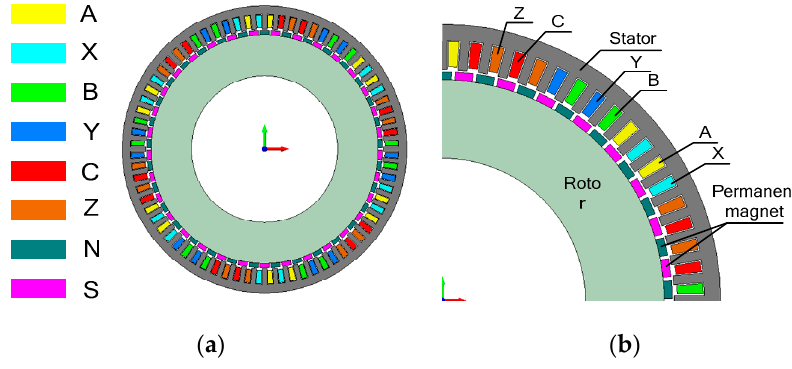
Figure 1. The structure of the DDPMSM: ( a ) overall structure; ( b ) local enlarged view. Table 1. The main parameters of the